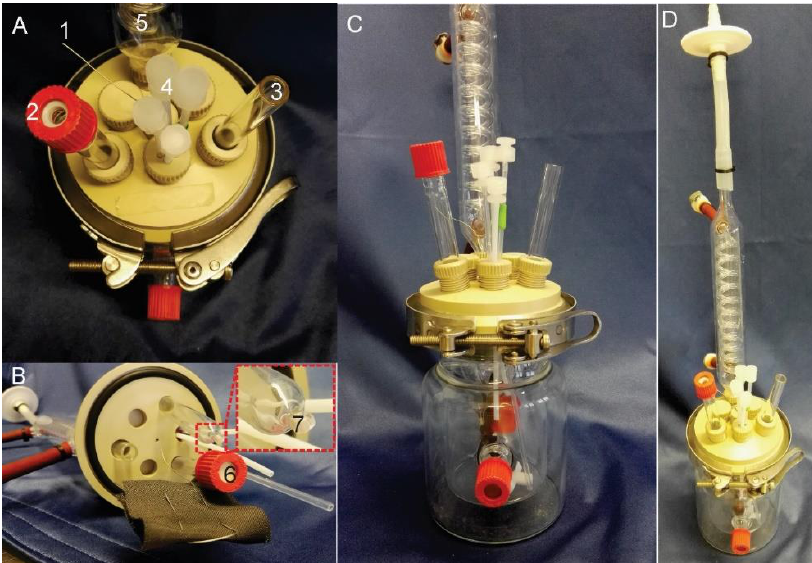
Figure 2. Pictures of the assembled BES reactor. ( A ) top-view; ( B ) bottom view of the lid; ( C ) and ( D ) overview from the side. 1, working electrode electric wire; 2, top-end of the bridging tube; 3, top-end of the counter electrode compartment; 4, four-port plug for gassing, sampling and feeding; 5, condenser; 6, bottom-end of the counter electrode compartment, sealed by an ion exchange membrane; 7, bottom-end of the bridging tube, sealed by porous glass frit (pore size of < 1 µm).